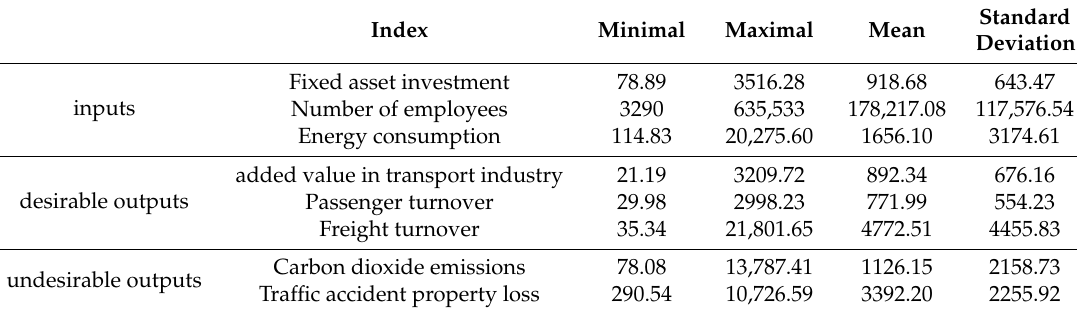
Figure 2. Total carbon emissions of integrated transport. Table 2. The statistical description of input and output indexes.